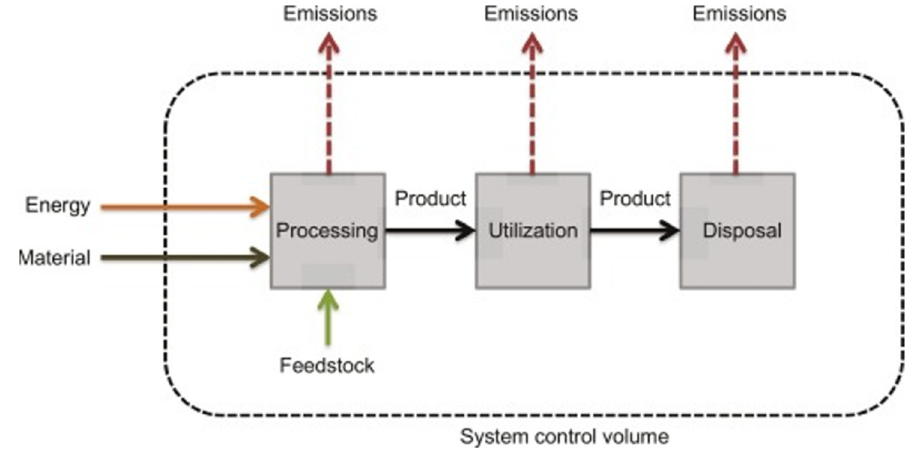
Figure 1. GREET used to conduct LCA (Adapted with permission from [15]. 2022, Elsevier).